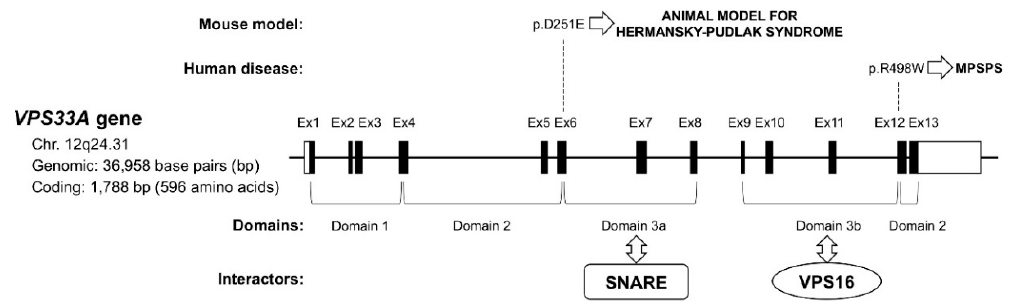
Figure 1. Schematic representation of the VPS33A gene. Exons (Ex, black boxes) and untranslated regions (white boxes) are indicated. Horizontal brackets indicate structural domains of the VPS33A protein, and known interaction partners are shown below. The p.D251E and p.R498W mutations are responsible for animal model (buff mouse) for Hermansky–Pudlak syndrome and human mucopolysaccharidosis-plus syndrome (MPSPS), respectively.